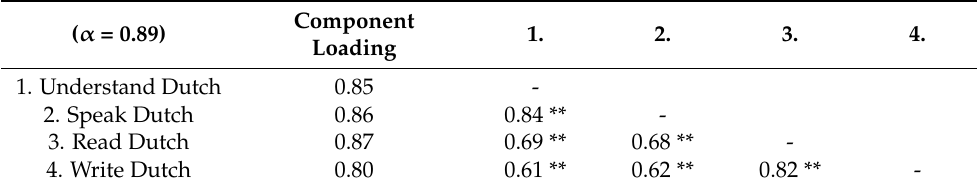
Table A1. Internal consistency, standardized component loadings, and correlations between items on Dutch proficiency (oblimin rotation).